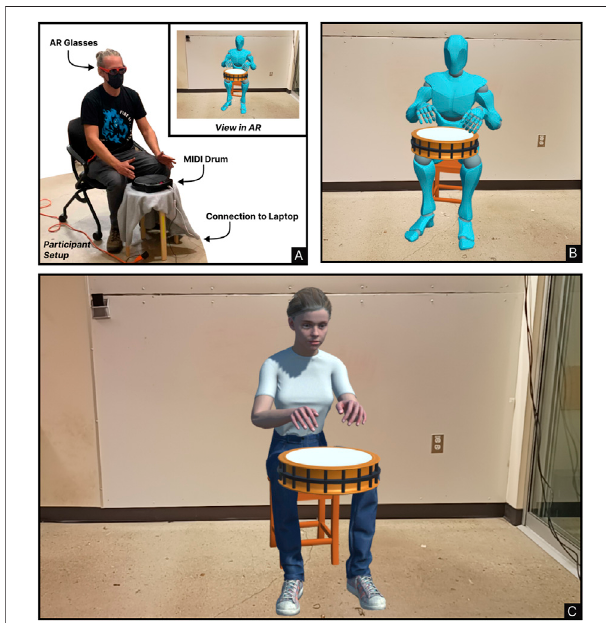
FIGURE 1 | (A) Representation of the Player 1 setup viewing Player 2 in AR, (B) Player 2 ’ s avatar as seen from the perspective of Player 1, and (C) Player 1 ’ s avatar as seen from the perspective of 2 in